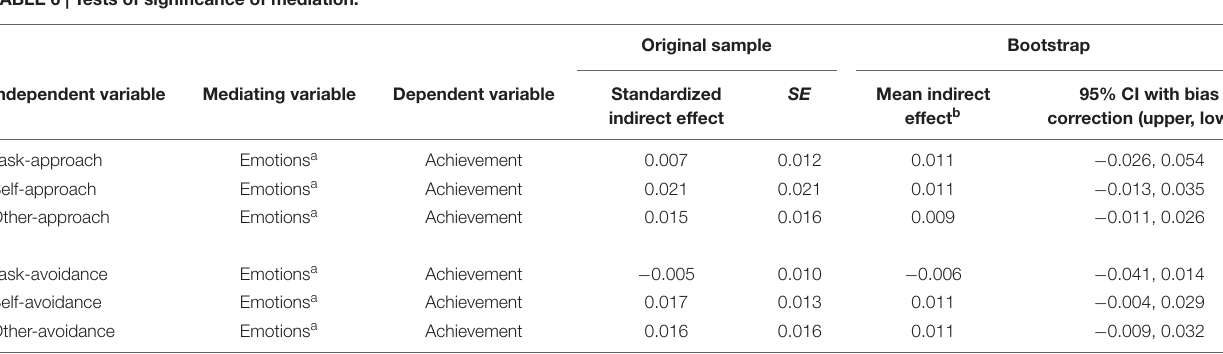
TABLE 6 | Tests of significance of